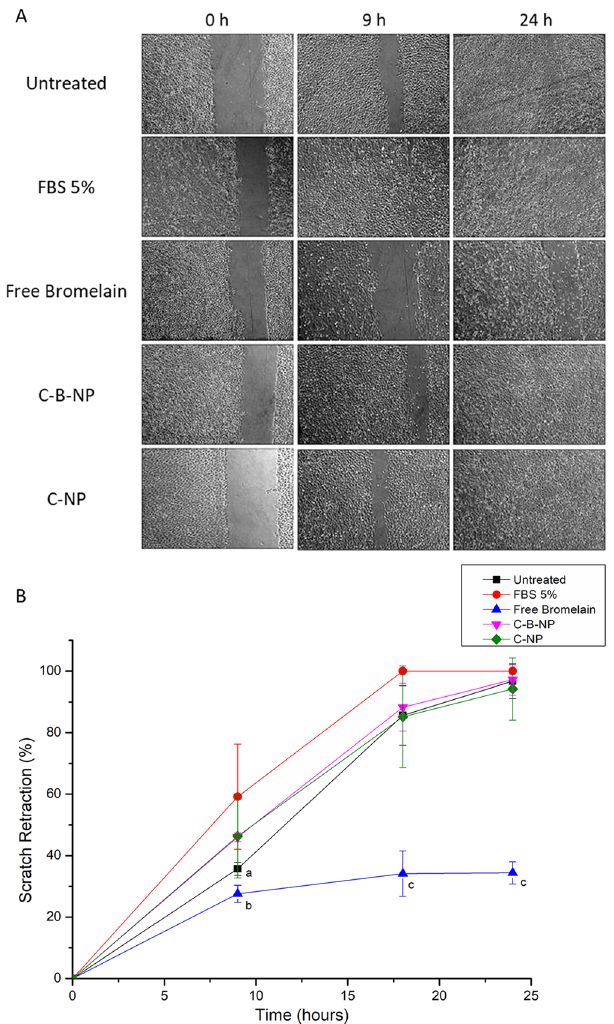
Figure 5. Representative micrographs of HaCaT (human non-tumor keratinocyte) cells treated with 250 µg/ mL of controls and samples for 0, 9 and 18 h (A) and scratch retraction percentage of controls and samples on scratch retraction during assay period (B). FBS fetal bovine serum, Chi-Brom NPs chitosan-bromelain nanoparticles, Chi NPs chitosan nanoparticles. Data is presented as mean ± standard deviation; n = 4. Letters represent statistical significance when comparing treatments in the same time point by Tukey’s test: a p < 0.05 when comparing scratch medium + FBS versus scratch medium; b p < 0.001 comparing scratch medium + FBS versus bromelain; c p < 0.001 comparing bromelain versus other treatments. Representative micrographs were chosen from micrographs taken by authors during in vitro scratch assay. Those micrographs were used to calculate the wound area and percentage of wound closure during assay, which was used by authors to create the